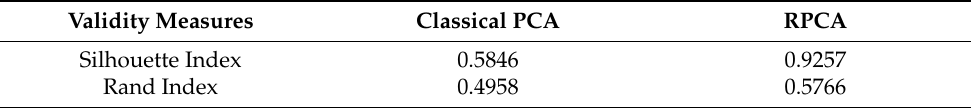
Table 8. Indices to measure the quality of the clustering results of the simulation